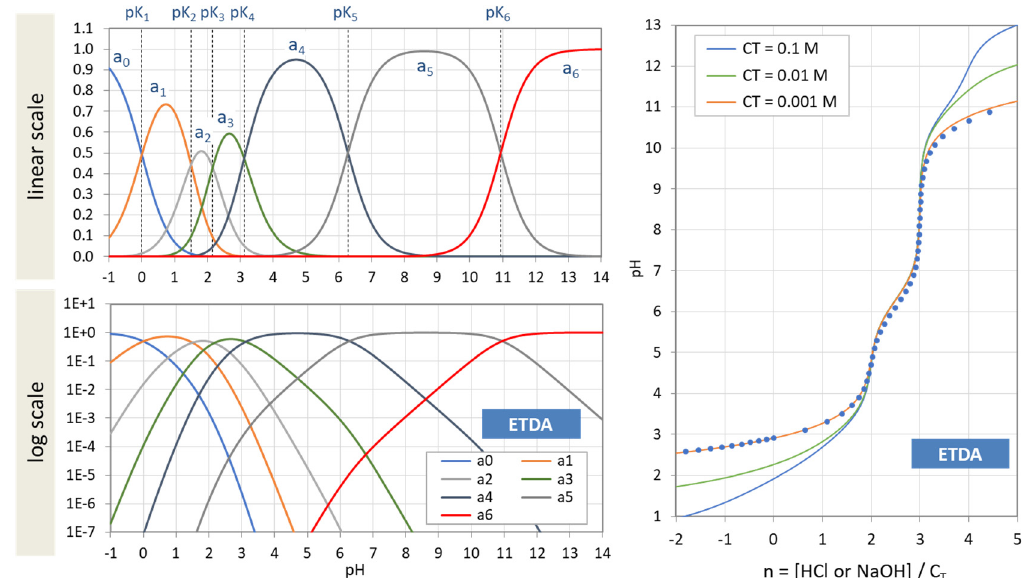
Figure 39. (Left) : Ionization fractions of EDTA in linear scale (top) and logarithmic scale (bottom). ( Right) : Titration curves of EDTA for three values of C T based on Equation (138). The red dots represent numerical calculations with PhreeqC. [Note: Complexation with Na is